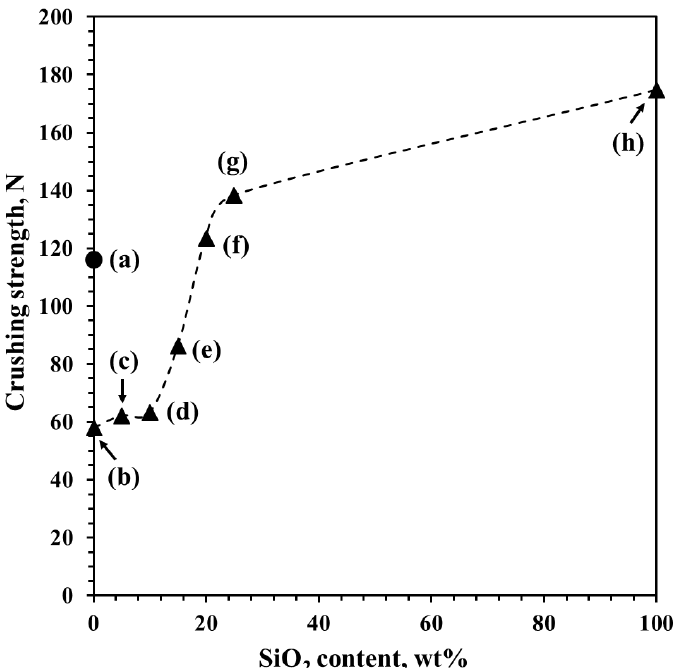
Figure 1. Tests of crushing strength of the macrospheres calcinated at 550 ◦ C: ( a ) commercial Al 2 O 3 , ( b ) Al 2 O 3 (100A), ( c ) 5 wt% SiO 2 –95 wt%Al 2 O 3 (5SA), ( d ) 10 wt% SiO 2 –90 wt% Al 2 O 3 (10SA), ( e ) 15 wt% SiO 2 –85 wt% Al 2 O 3 (15SA), ( f ) 20 wt% SiO 2 –80 wt% Al 2 O 3 (20SA), ( g ) 25 wt% SiO 2 – 75 wt% Al 2 O 3 (25SA) y ( h ) SiO 2 (100S). Resistance to rupture refers to spheres with a diameter